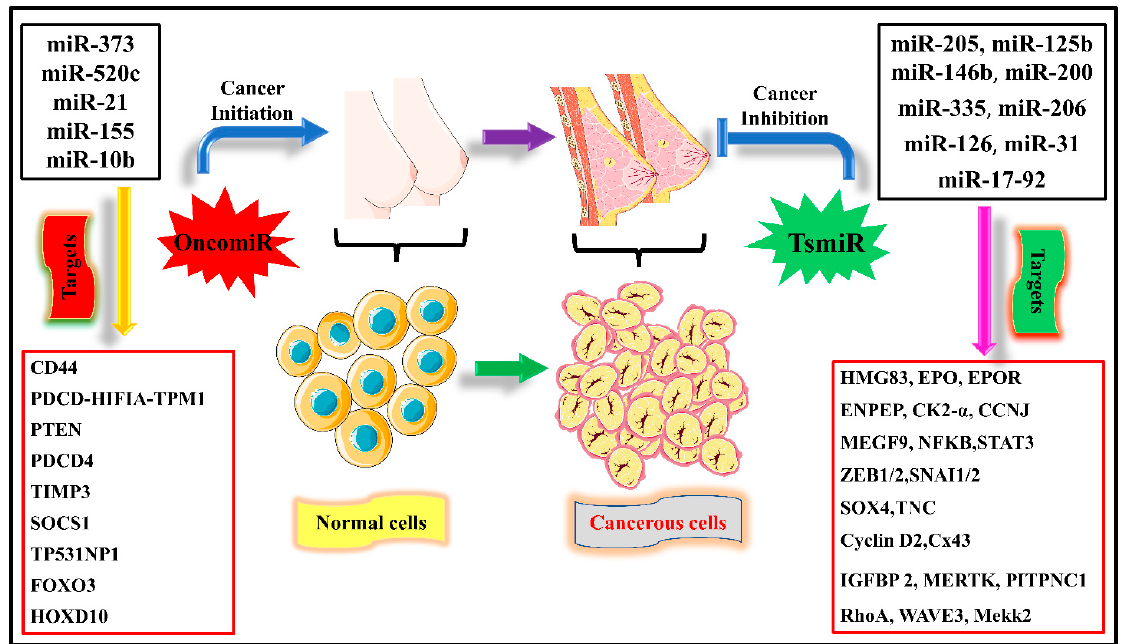
Figure 1. An overview of various miRNAs responsible for initiating cell proliferation and invasion in breast cancer, which are called oncogenic miRNAs (oncomiRs). While miRNAs responsible for tumor suppression are tumor suppressor miRNAs (TS miR), whose main function is the inhibition of migration, invasion, proliferation, and apoptosis. Different miRNAs have different targets for their activity in suppressing tumor growth.